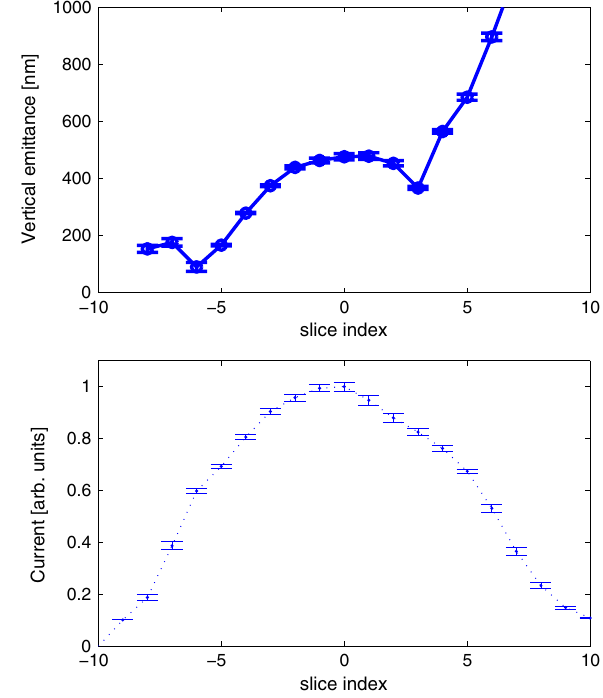
FIG. 9. Vertical slice-emittance measurement. Normalized emittance (upper plot) and current (lower plot) as a function of the slice